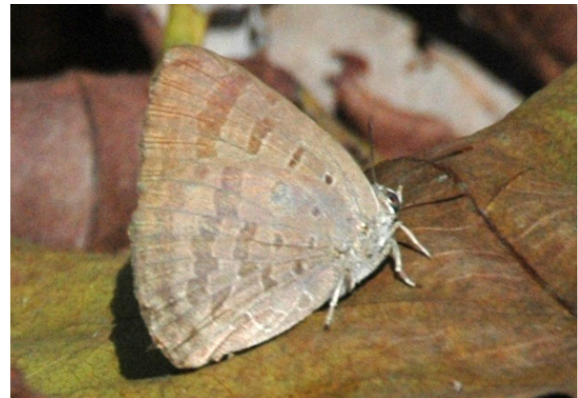
Image 10. Indian Oak Blue Arhopala atrax